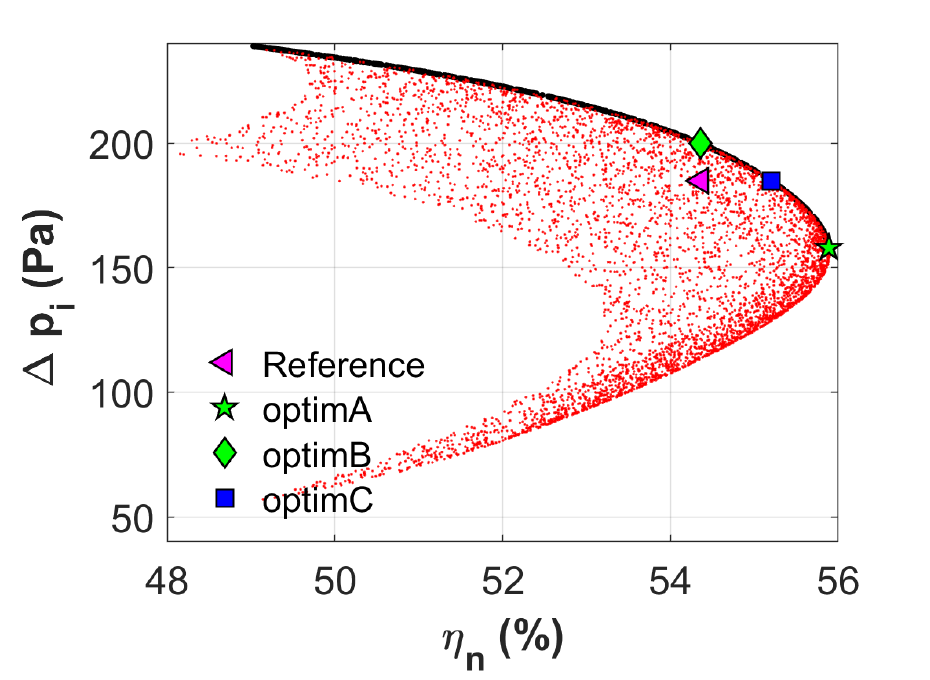
Figure 10. Pareto front of optimization: maximization of η n (2300 m 3 /h) and ∆ p i (2800 m 3